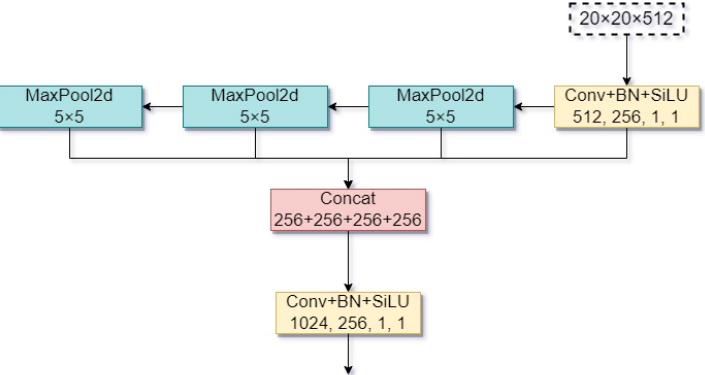
Figure 3. The diagram of SPPF structure in YOLOv5s.